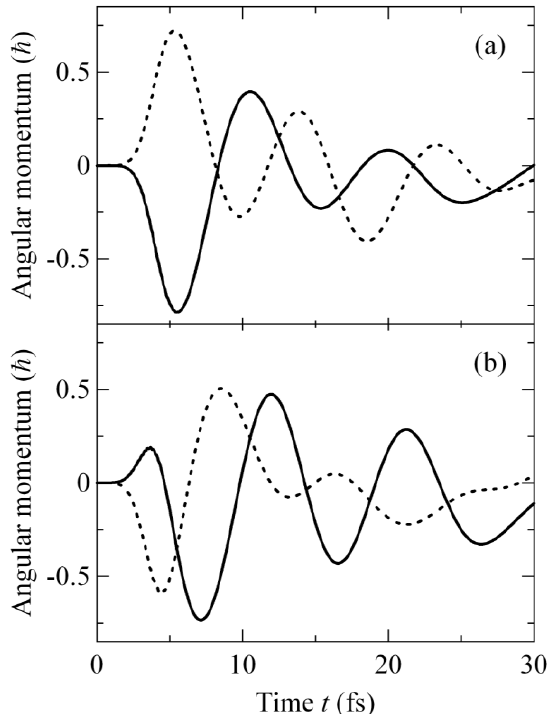
Figure 5. Expectation value of the electronic angular momentum l z ( t ) in DCP irradiated by ( a ) linearly and ( b ) circularly polarized VUV laser pulses calculated from nuclear WP simulations. In panel ( a ), the expectation values for e (+) and e (−) are denoted by the solid and dotted lines, respectively; in panel ( b ), those for e +1 and e − 1 are denoted by the solid and dotted lines, respectively. The laser pulses fully decay at t = 7.26 fs. Reprinted from [56] with permission of the American Chemical Society.